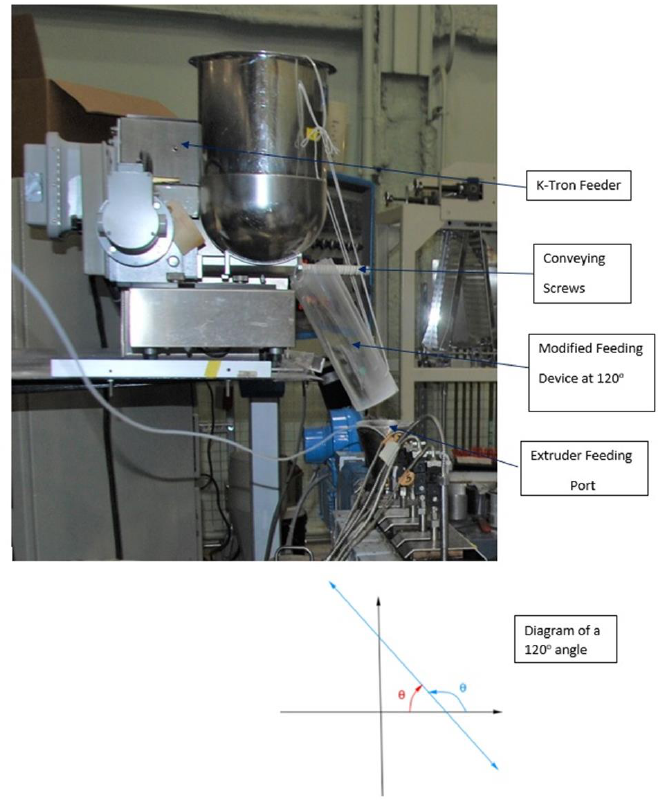
Figure 1. Modified feeding device for suitable conveying formulated flours, containing different levels of tiger nut, into the